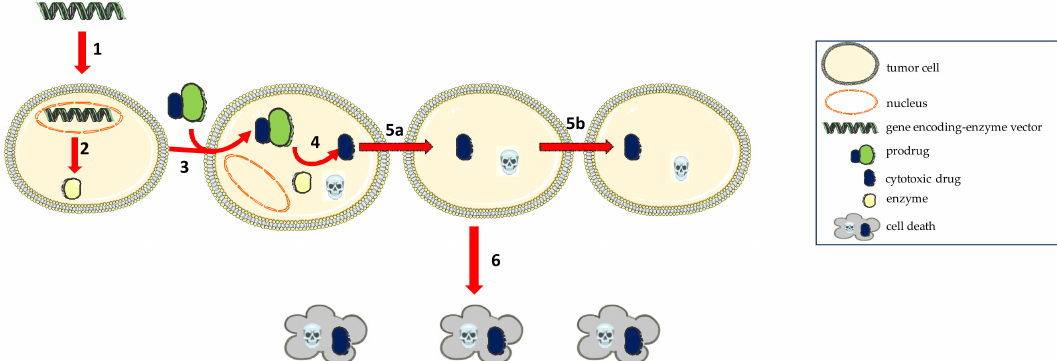
Figure 2. General representation of the GDEPT strategy involving the occurrence of the bystander effect. 1 − The gene encoding an enzyme, that is delivered at the target site; 2 − The triggering of the intracellular expression of the enzyme; 3 − Systemic administration of a prodrug; 4 − The activation of an inactive prodrug into an active cytotoxic agent, that leads to the transduced tumor cell death; 5a, 5b − The transfer of active metabolites to non-transduced neighboring cells; 6 − The destruction of distant